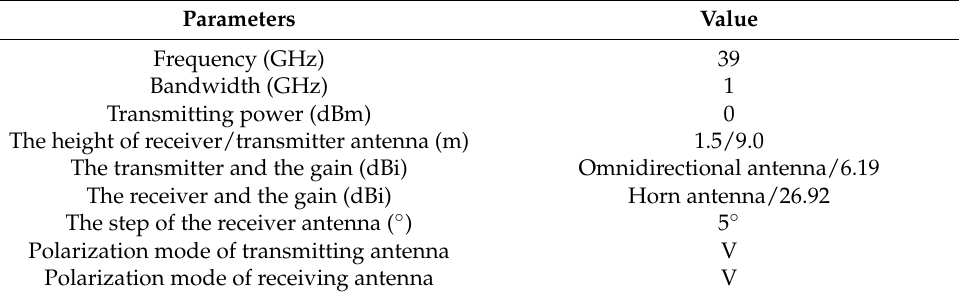
Table 1. Channel measurement parameters in the urban microcell.